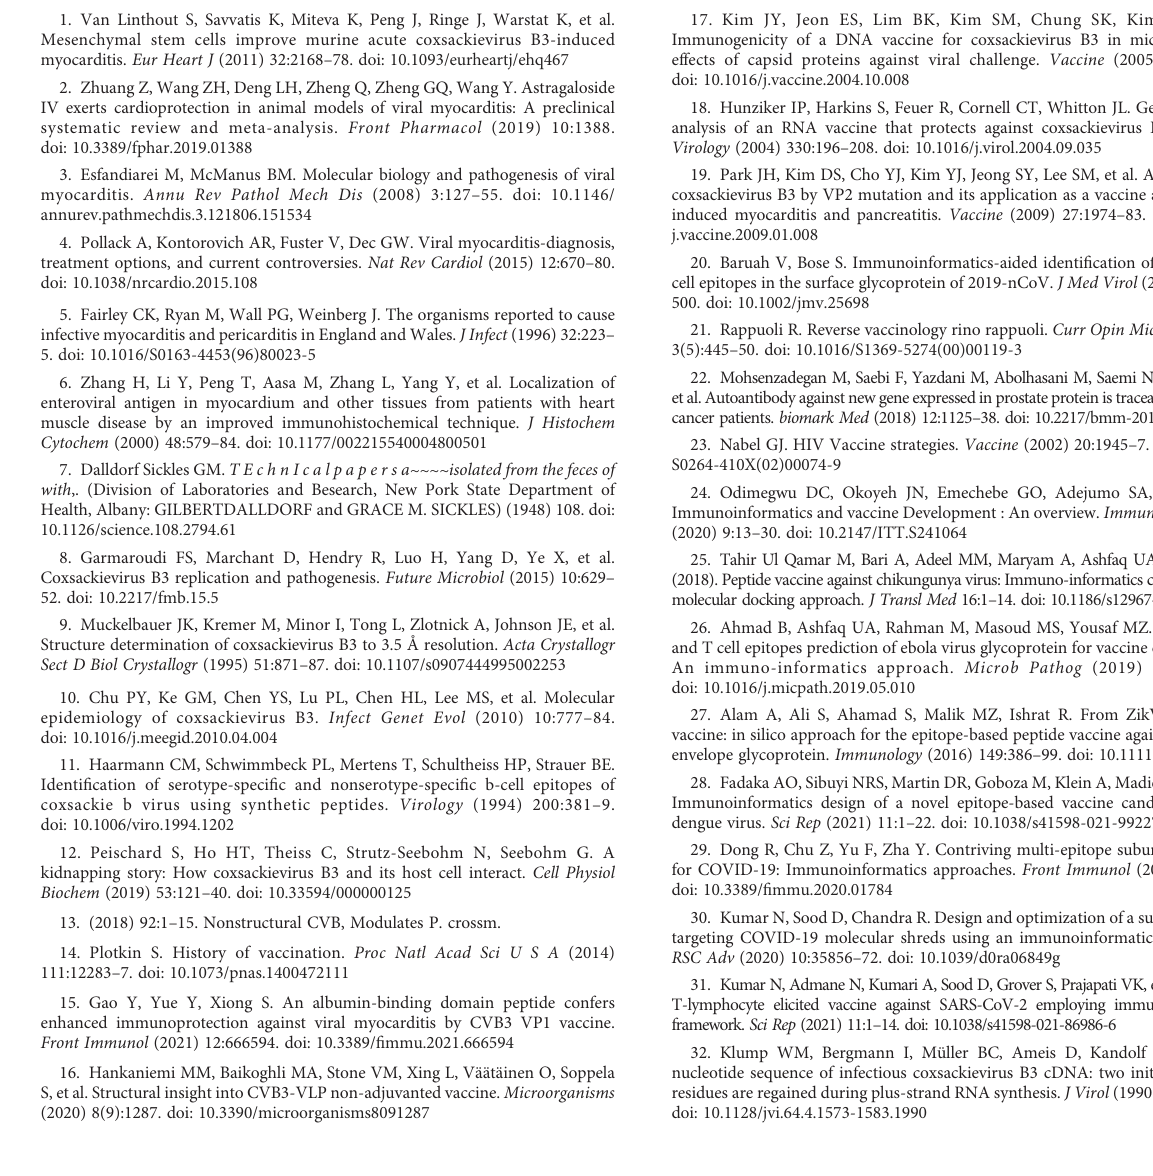
FIGURE S4 Analysis the interaction between the CVB vaccine and immune receptors (Salt bridges colored in rad); Disulphide bonds colored in yellow; Hydrogen bonds colored in blue; Non-bounder contacts colored in orange. (A) CVB vaccine and MHC-I. (B) CVB vaccine and MHC-II. (C) CVB vaccine and TLR3. (D) CVB vaccine and TLR4. FIGURE S5 In silico cloning of the CVB vaccine in the vector, pET28a (+). Red areas represent the CVB vaccine, while the black areas represent the expression vector, pET28a (+). FIGURE S6 The secondary structure of the designed vaccine